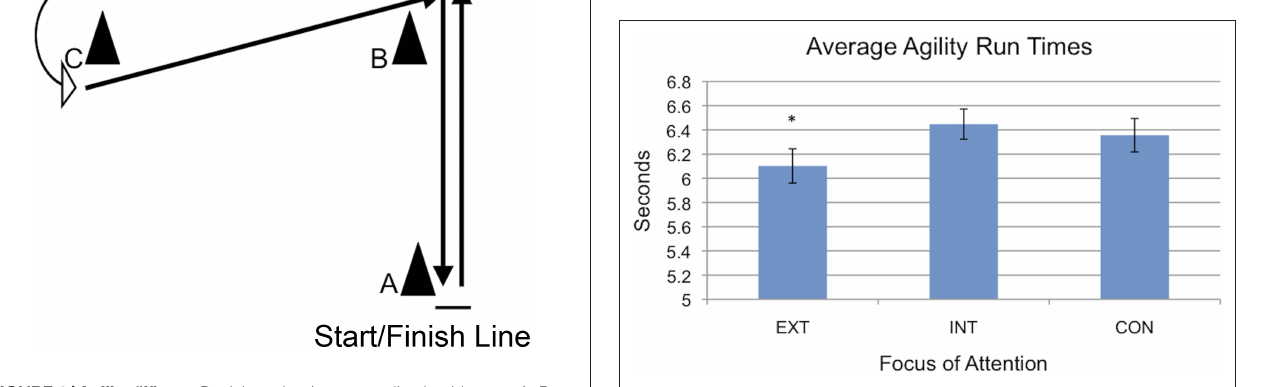
Figure 2 | Agility run times for the external (eXT), internal (iNT), and control (CON)